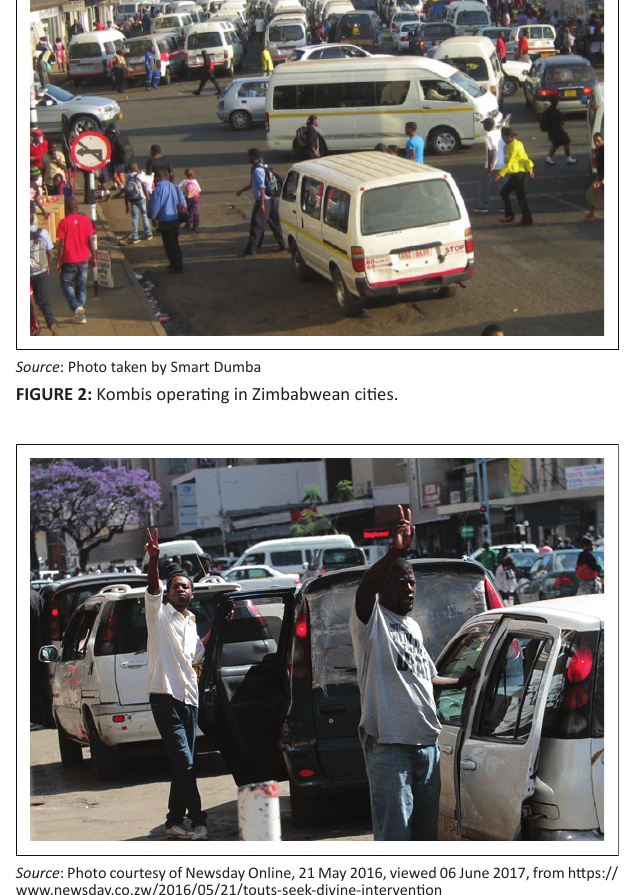
FIGURE 3: Pirate taxis operating in Zimbabwean